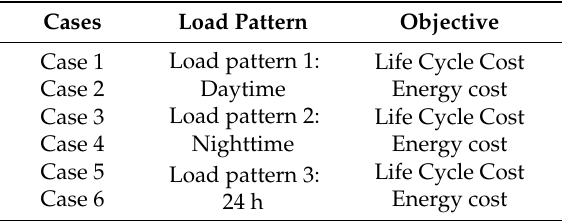
Figure 4. Conceptual diagram of system configuration. HP: Heat pump; HST: Heat storage tank.